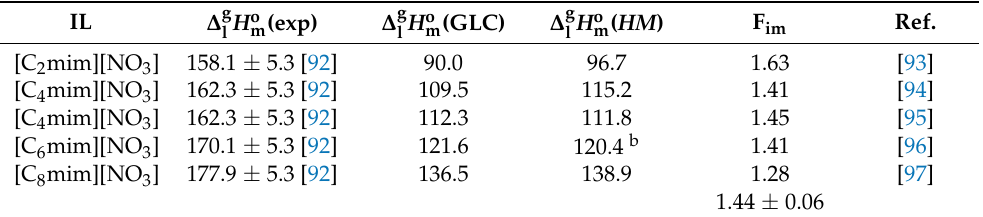
Table 5. [C n mim][NO 3 ] series: comparison of ∆ g Equations (5) and (6) with experimental results from conventional methods a .